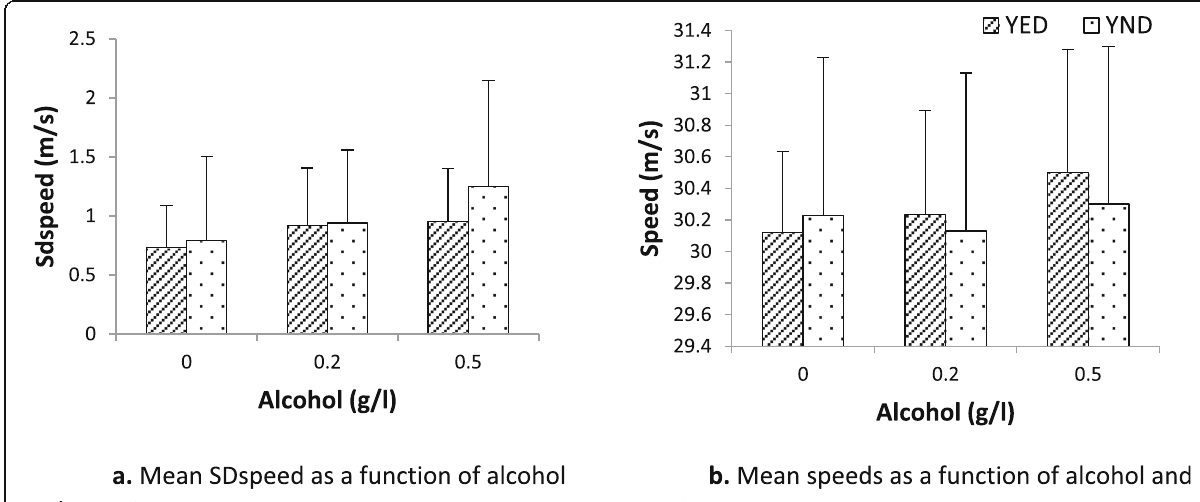
Fig. 4 a Mean SDspeed as a function of alcohol and experience. b Mean speeds as a function of alcohol and